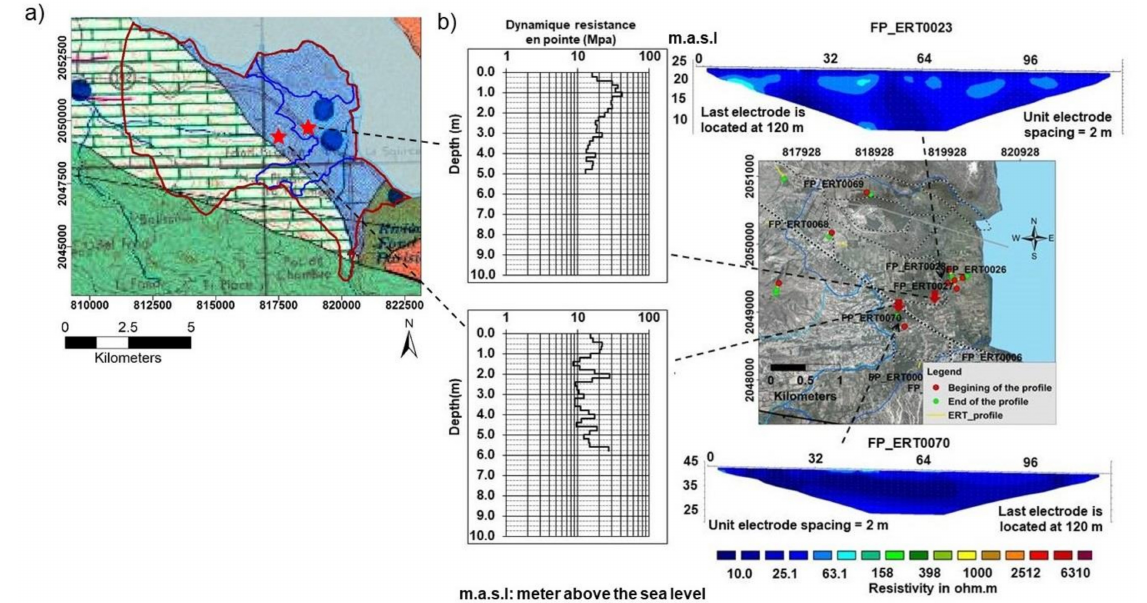
Figure 15. ( a ) Hydrogeological map (1/250,000) of Fond Parisien extracted from the hydrogeological map of Haiti—with blue zone indicating very shallow water table in soft sediments (see also stars locating the penetrograms and ERTs shown in ( b ). ( b ) Standard tests penetrometers realized in the sedimentary basin of Fond Parisien together with some ERT sections. The penetrograms reveal mean compactness ranging from 10 to 30 MPa over the 5 m thick investigated, thus denoting poorly compacted soils; a geotechnical borehole completed in the village “La Source” of Fond Parisien in the south of the lower ERT is shown in the annex in Figure